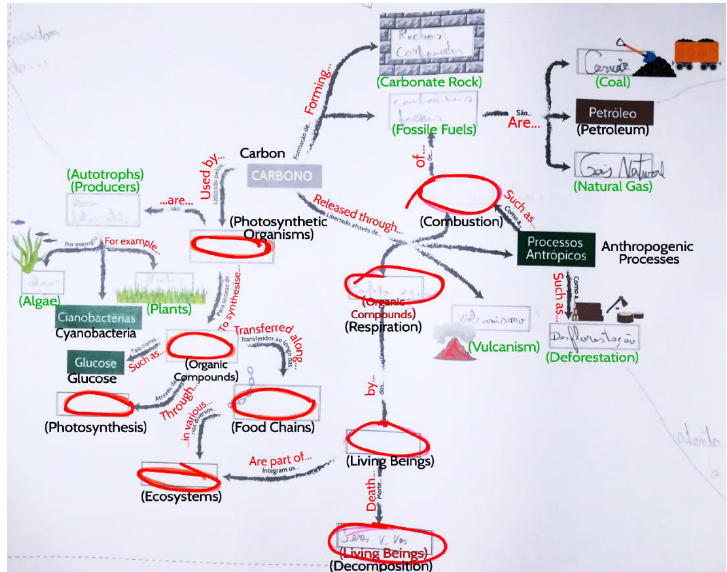
Figure 3. Example of one of the most uncompleted and incorrectly filled concept map (carbon cycle). All empty boxes or incorrect terms are circled in red. Two terms in red were incorrectly placed (*). Terms in green are correctly placed. Terms in black represent the correct term.